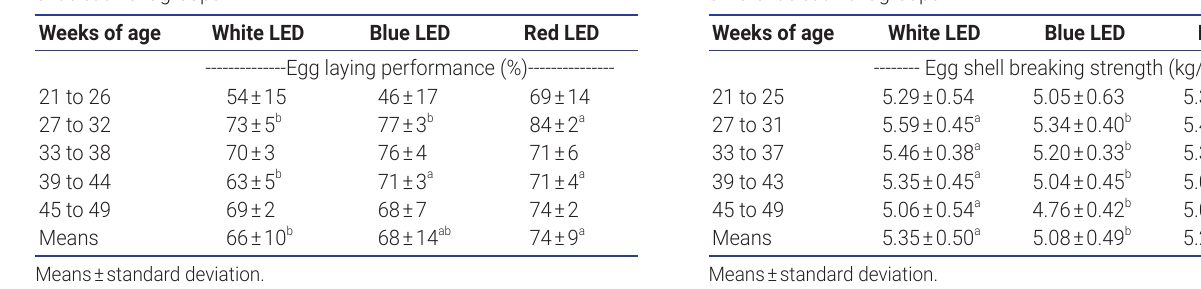
Table 5. The egg shell breaking strength of Brown Tsaiya ducks in different treatment